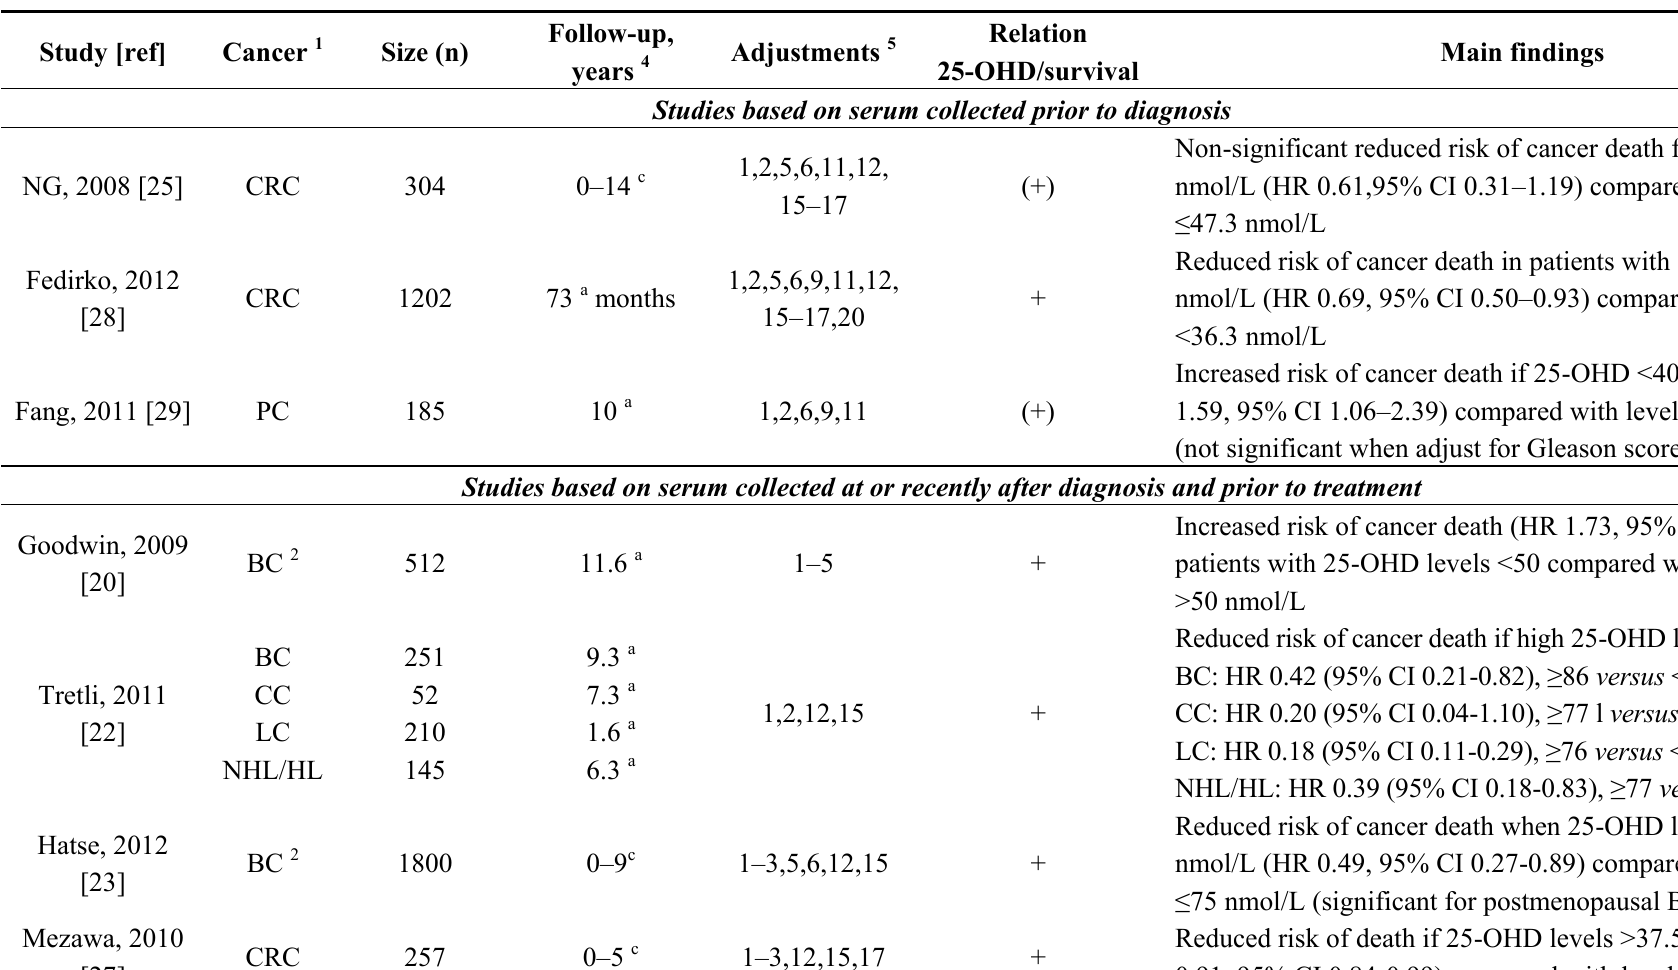
Table 1. The studies investigating the relationship between circulating level of 25-OHD and cancer survival, grouped by time for serum sampling with regard to time of diagnosis and